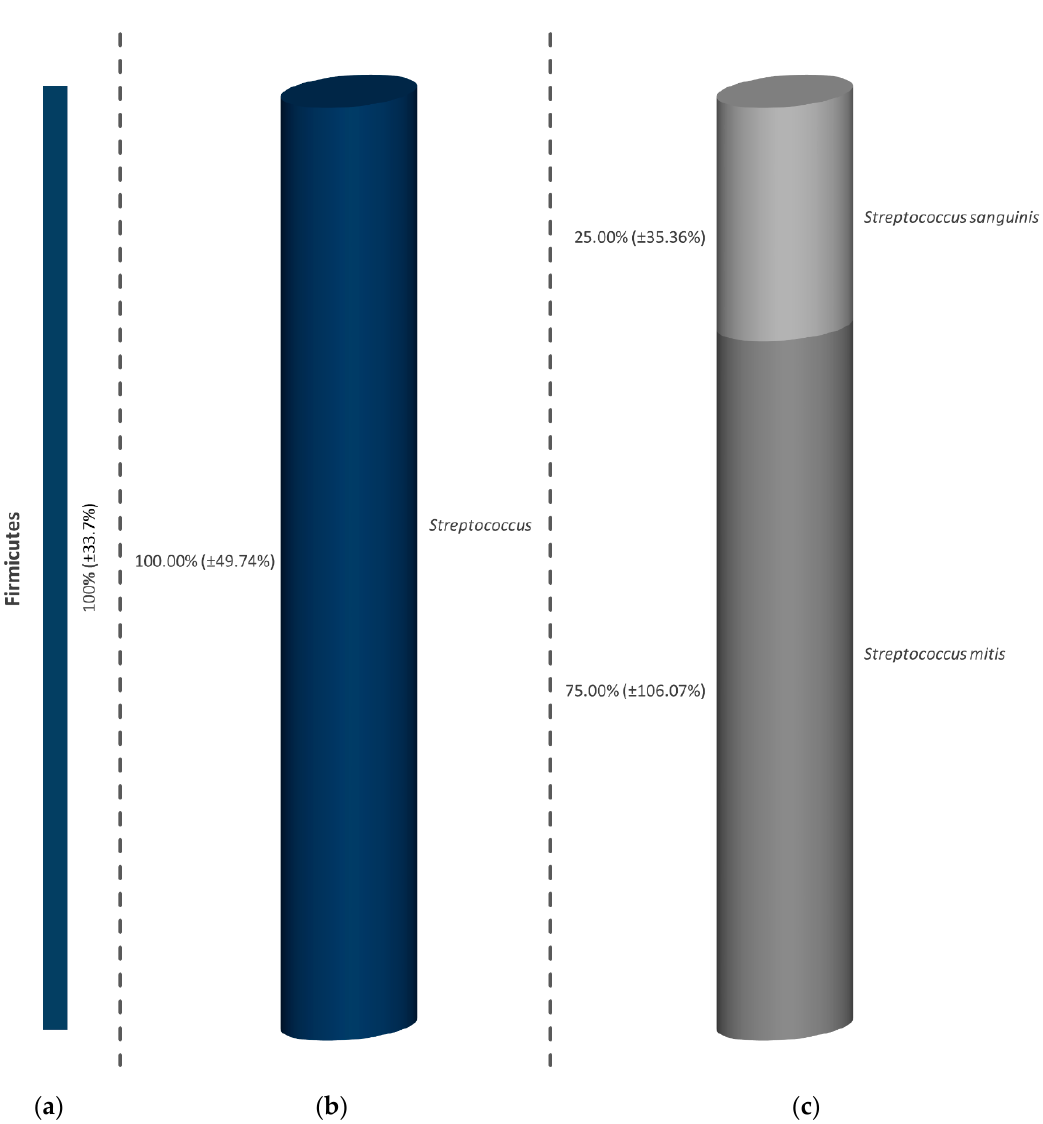
Figure 2. Graph of the surviving microorganisms after treatment of the initial biofilm with CHX. The subdivision is made into strain ( a ), genus ( b ) and bacterial species ( c ), whereby the occurrence is given in percentage, based on the total number of all detected bacteria in all subjects. The bars depict the average values in percentage of three discs (one from each volunteer). In addition to the average values, the standard deviations are also presented in parentheses. The high standard deviations are caused by the fact that bacteria were detected only in the initial adhesion of two volunteers after the treatment with CHX. All of these bacteria are members of the genus Streptococcus, of which Streptococcus mitis was detected only in the initial biofilm of one volunteer and Streptococcus sanguinis survived in the initial oral biofilm of two participants.